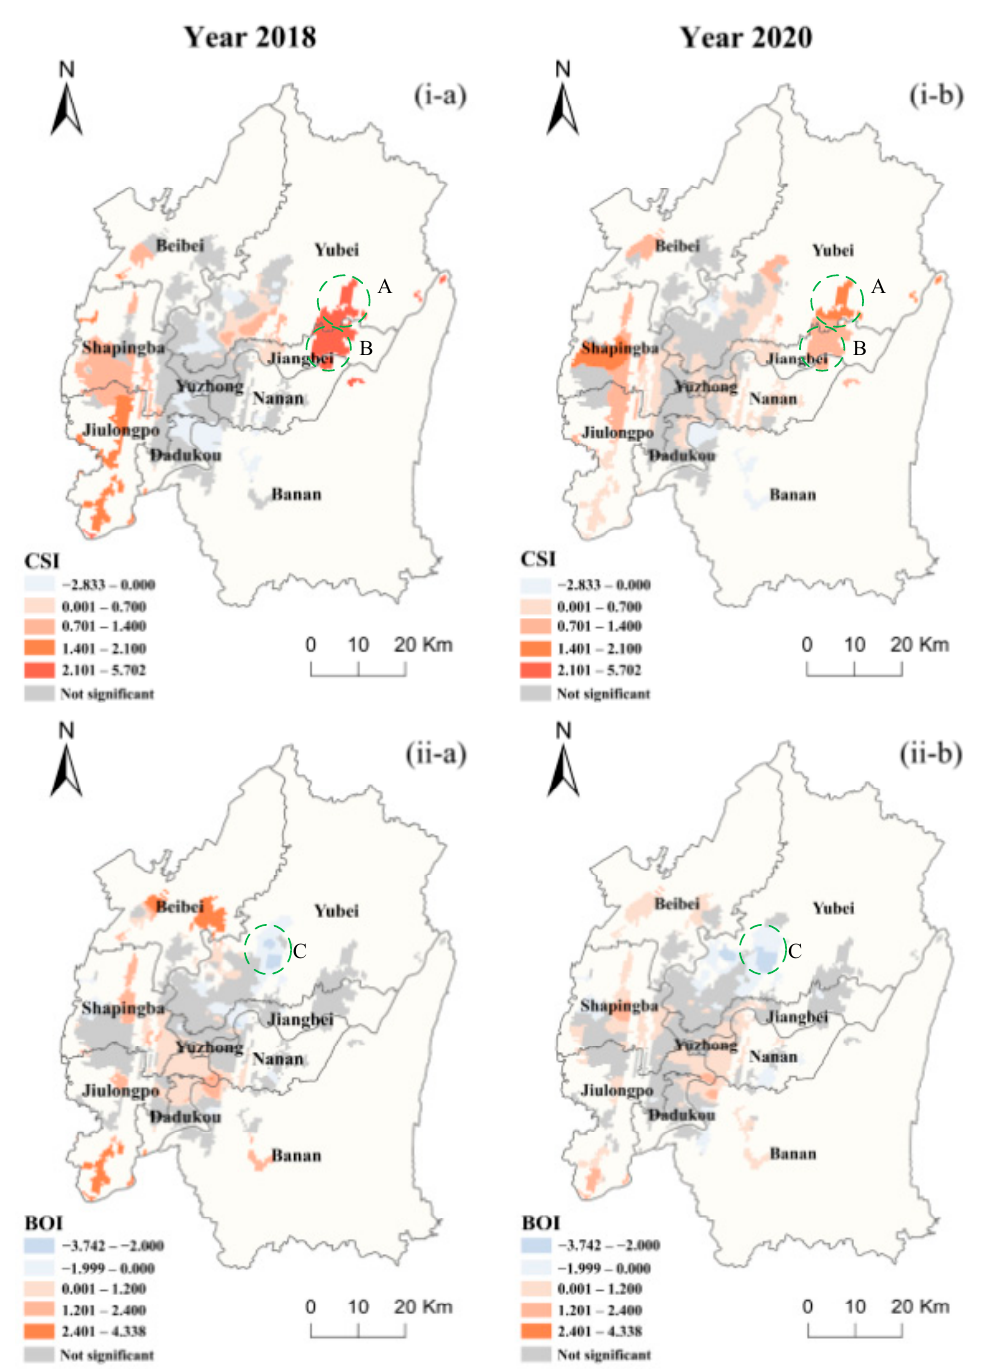
Figure 7. Spatial distributions of the coefficients of ( i ) commercial services index and ( ii ) business office index in ( a ) 2018 and ( b ) 2020 (CSI: commercial service index; BOI: business office index. Region A is the Longxing town; Region B is the Yufu town; Region C is the Airport).